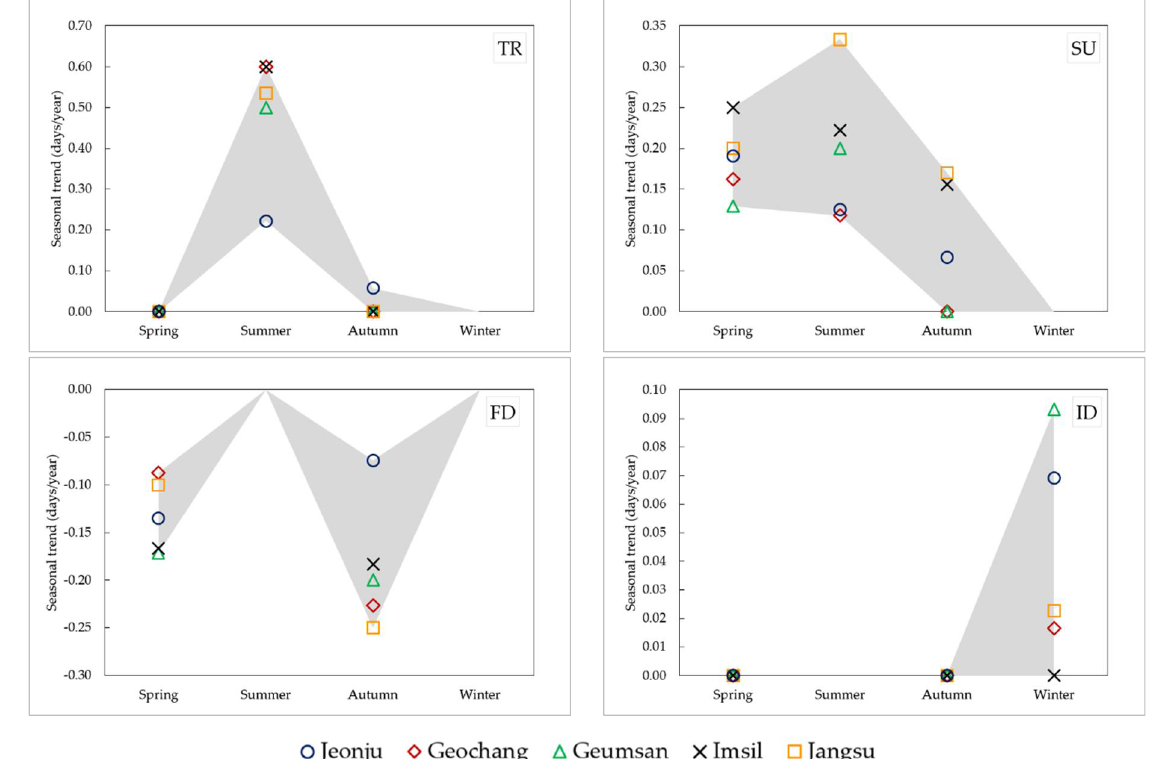
Figure 5. The seasonal trend magnitudes of heat and cold duration indices at the UGRB.